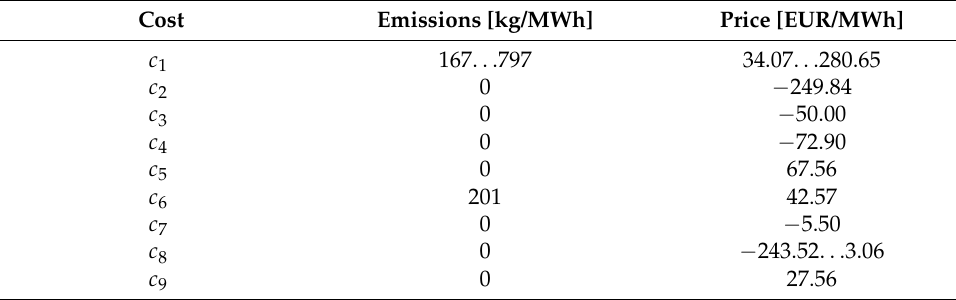
Figure 3. Energy system graph with the energy sectors electricity in green, heat in orange, and gas in yellow. The purple dots mark costs considered in the model, see Table 1 for details. Table 1. Specific costs assumed in the